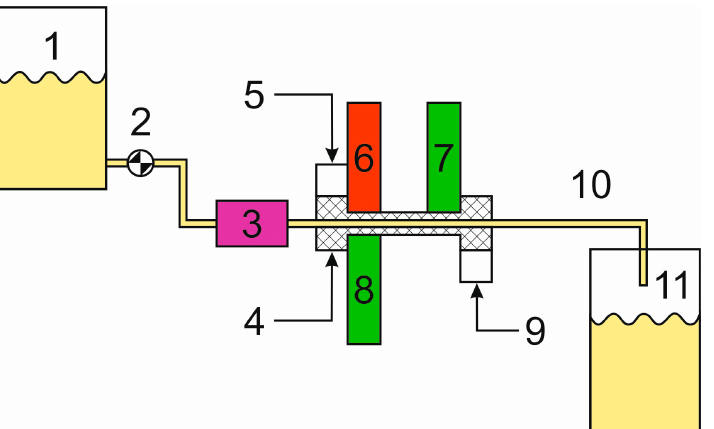
Figure 8. Block diagram of the setup for measuring laser extinction with multichannel fiber-optic bundles: (1) milk container, (2) tap, (3) pump, (4) measuring cell, (5) air bubble generator, (6) fiber bundle with laser diode (850 nm, 200 mW), (7) randomized fiber bundle with a photodetector, (8) tial type, (10) model of milk pipe with a cross-sectional diameter of 3 mm, (11) receiving container for milk.